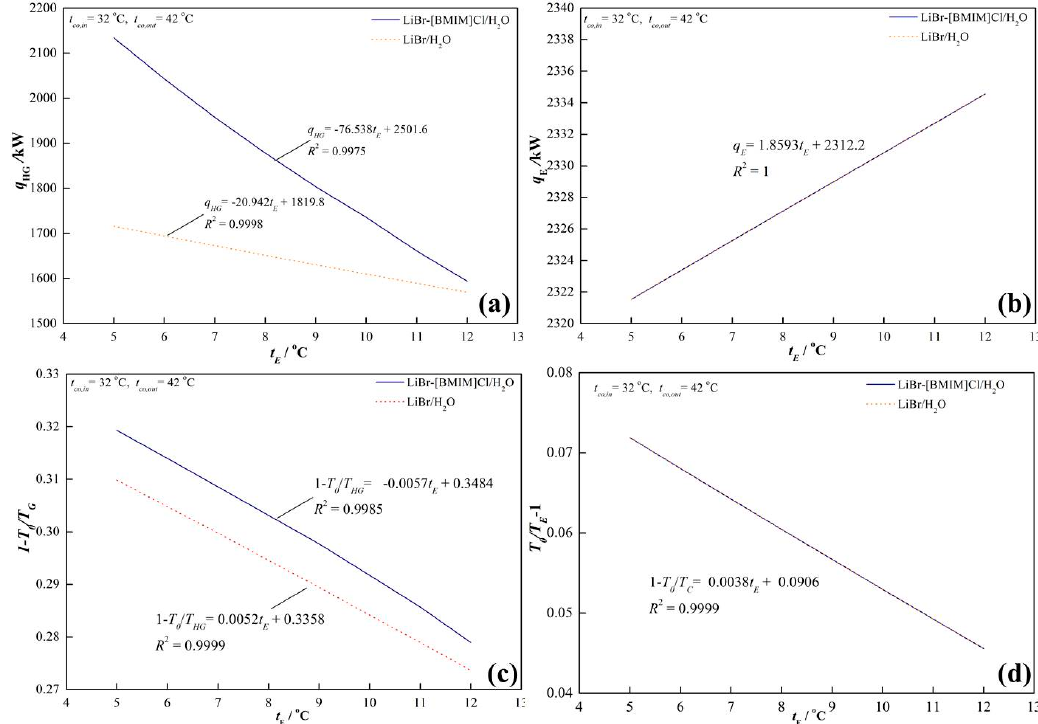
Figure 12. Variations of the specific heat loads and their quality with the evaporation temperature t E . ( a ) q E ; ( b ) q HG ; ( c ) (1 − T 0 / T HG ); ( d ) ( T 0 / T E −